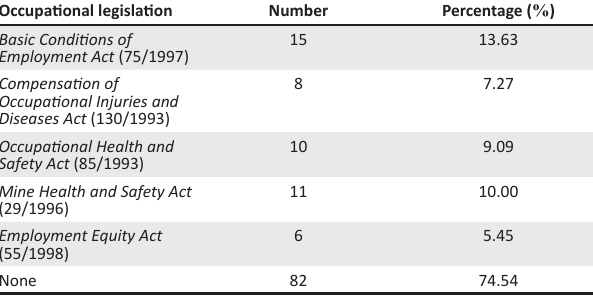
TABLE 1: Participants’ knowledge of occupational legislative acts ( n =